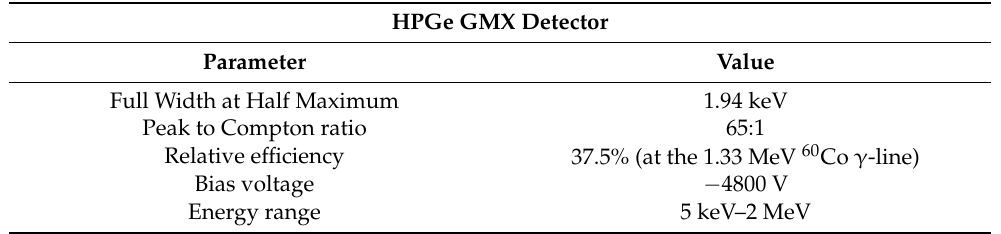
Table 1. The HPGe GMX operating